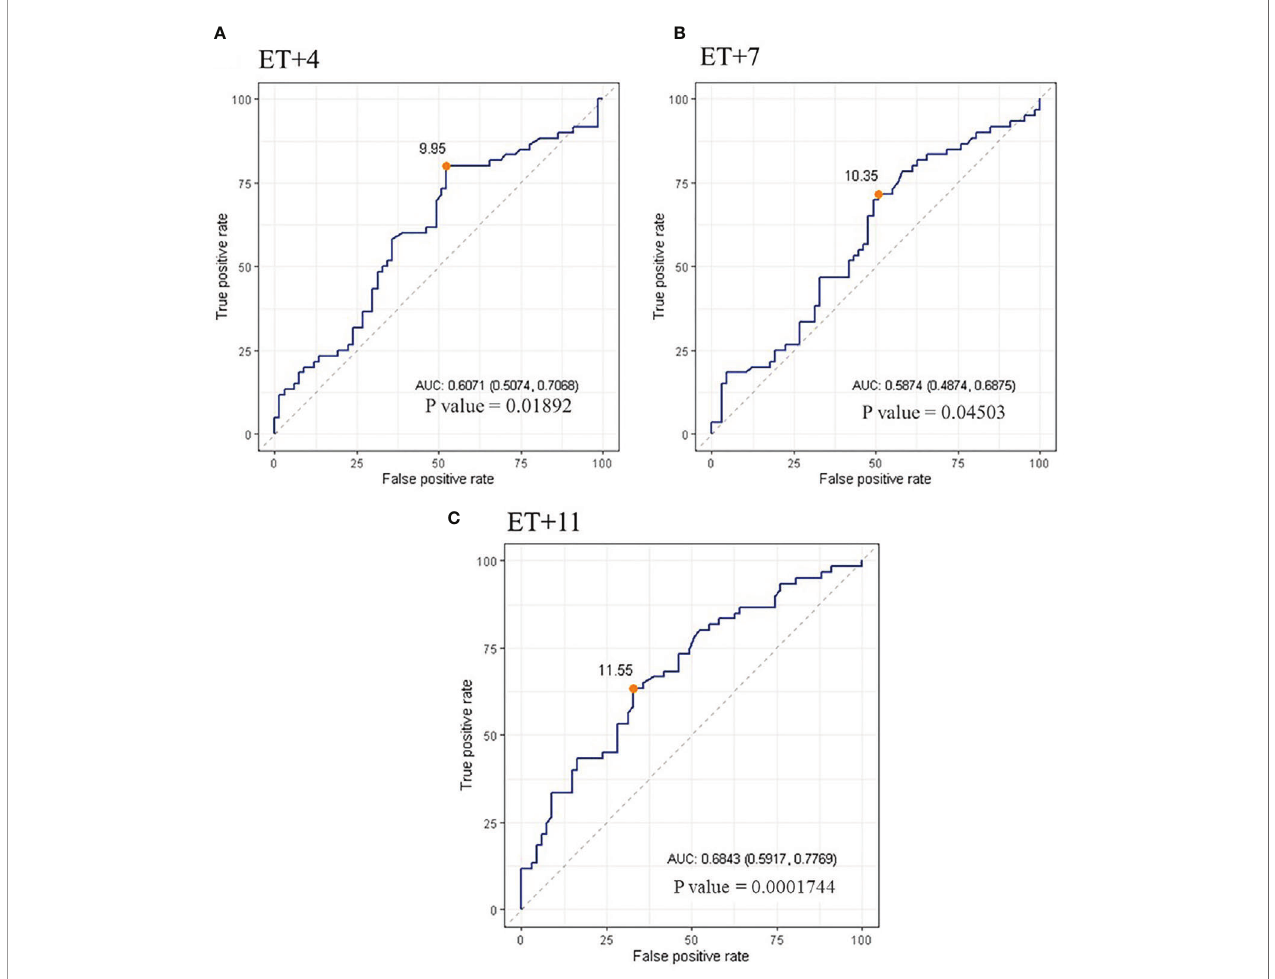
FIGURE 4 | ROC curve of serum P levels on day 4 (A) , 7 (B) and 11 (C) after ET. The orange dot points out the cut-off value calculated yielding the best sensitivity and speci fi